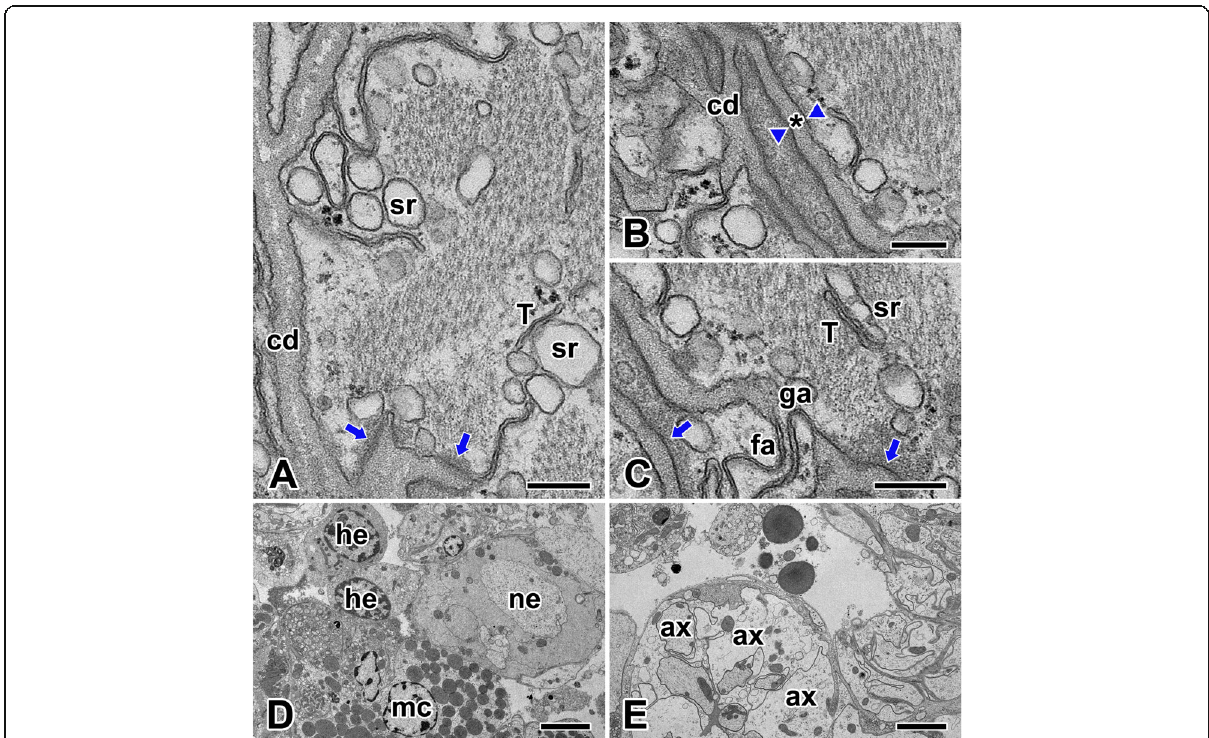
Fig. 5 Electron micrographs of the intercalated disc and neural innervation of cardiac muscle cells in N. clavata . a : Intercalated disc (cd) is formed by deep penetration of the sarcolemma. Coupling of transverse tubules (T) and terminal cisternae of sarcoplasmic reticulum (sr) are observed. b : Intercalated discs are composed of dense layer of sarcolemma, two plasma membranes (arrowheads), and a regular interspace (asterisk). c : Gap junctions (ga), fascia adherens (fa), and macula adherens (arrows) junctions are seen. d , e . Cardiac muscle cell (mc) is innervated by a branch of external nerves (ne). A bundle of axons (ax) extend across the heart and penetrate the myocardium. Scale bars indicate 0.25 μ m ( a-c ), 5 μ m ( d ), and 2.5 μ m ( e ),